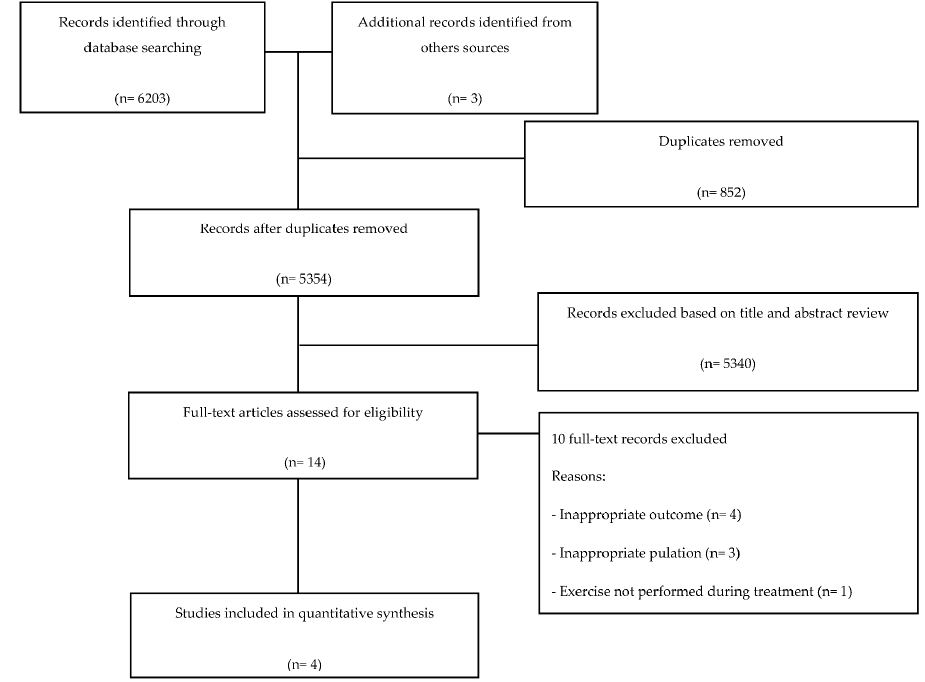
Figure 1. Flow of trials through the selection process.